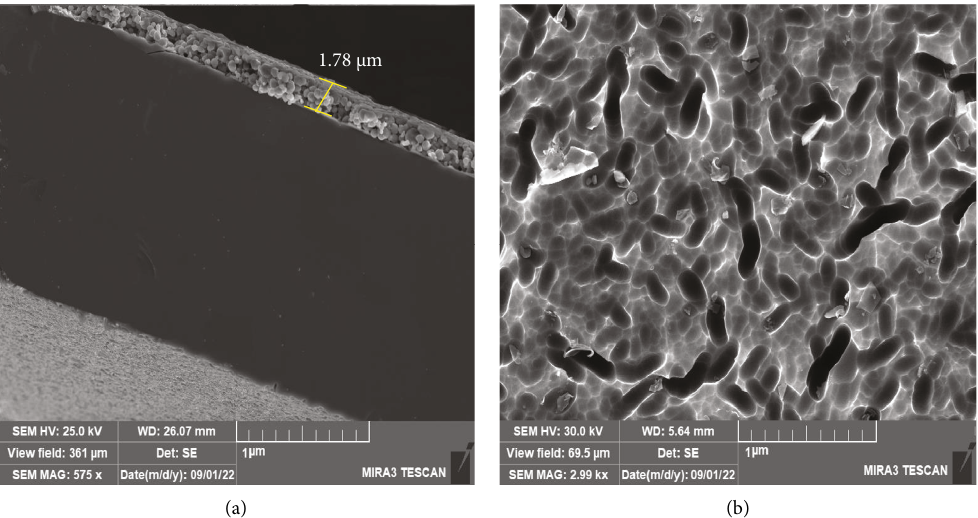
Figure 3: (a) FESEM Cross-sectional image—F3 solar cell sample. (b) FESEM surface morphology—F3 sample.